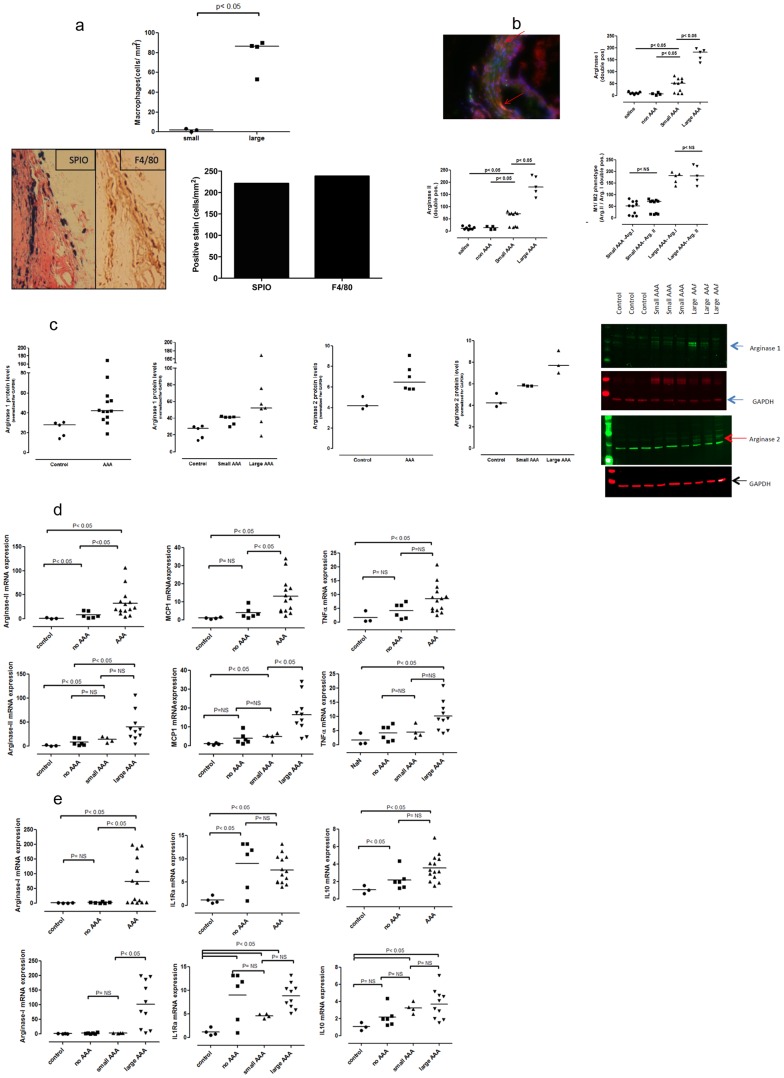
Macrophage expressions in AAA.(A) Analysis of macrophage accumulation in AAA. Prior to sacrifice, mice were injected with SPIO particles via lateral tail vein injections. SPIOs are phagocytosed by macrophages, and are evaluated histologically by Prussian Blue (PB) staining thereby providing an assessment of the presence and activity of macrophages. Top: Analysis using stereology showed a clear increase in positive iron bound macrophages in large aneurysms compared to small aneurysms (small AAA n = 3, large AAA n = 4; p<0.05). Bottom right: Automated quantitative analyses of histological sections of PB and F4/80 stains for macrophages showed congruence in the degree of macrophage accumulation as detected by both methods. Data shown were obtained from analyses of large AAAs; however, similar results were noted for small AAAs (data not shown). Bottom left: Representative histological sections showing SPIO and F4/80 stains for macrophage. Parallel findings from F4/80 and PB stains demonstrates the fidelity of SPIO particles for delineating the presence and activity of macrophages. AAA, abdominal aortic aneurysm; SPIO, supraparamagnetic iron oxide; PB, Prussian Blue. (B) M1 and M2 macrophage phenotypes and AAA. Presence of markers of M1 (arginase II) and M2 (arginase I) in cross sections of normal and aneurysmal tissue was evaluated using immunofluorescence staining (control n = 7, no AAA n = 4, small AAA n = 10 and large AAA n = 5). Increased numbers of positive stains were observed in both small and large aneurysms for both arginase I and arginase II. Expression of arginase I and II were significantly more increased in larger aneurysms. (C) Western blot Analysis of markers of M1 and M2 phenotypes and AAA. Left panels: Protein expression of arginase I as measured by western blot shows a statistically significant increase in arginase I in AAA tissue versus control (control n = 5, AAA n = 13; p p<0.05). Expression of arginase I was higher in large AAA versus small AAA. The observed difference was statistically significant (small AAA n = 6, large AAA n = 7; p<0.05). Middle panels: Protein expression of arginase II as measured by western blot shows small but statistically significant increases of arginase II in AAA tissue versus control (control n = 3, AAA n = 6; p<0.05). Expression of arginase II shows statistically significant differences between control, small and large AAA (small AAA n = 3, large AAA n = 3; p<0.05). Right panel: Representative images of western blot for arginase I and II. (D) Gene expression analysis of markers of M1 phenotype and AAA Left panel: Arginase II gene expression is significantly increased in tissues from both AAA (>23 fold, n = 14) and no AAA (>6 fold, n = 6) mice versus controls (n = 3). The difference between mice with and without AAA (>3 fold) is statistically different. In both small (n = 4) and large AAA (n = 10) the expression of arginase II is significantly different compared to control; however differences between small/large and small/no AAA were not significant. Middle panel: AAA mice had increased expression of MCP1 (>9 fold) compared to those without AAA and controls; both small and large AAA mice had increased expression of MCP1 (p<0.05) compared to controls, and the difference between small and large was significant (p<0.05; control n = 3, no AAA n = 6, small AAA n = 4 and large AAA n = 10). Right panel: TNF-α expression was significantly increased in the presence of AAA (>7 fold increase versus controls). Although both small and large AAA show increased expression (small >4 fold, n = 4, large >9 fold) only the latter differed significantly from controls. Observed differences between large and small AAA were not statistically significant (control n = 3, no AAA n = 6, small AAA n = 4 and large AAA n = 10). (E) Gene expression analysis of markers of M2 phenotype and AAA Left panel: When the size of aneurysm is considered we observed that arginase I expression in small AAA did not significantly differ from that of control but did differ significantly from the expression in large AAA (control n = 3, no AAA n = 6, small AAA n = 4 and large AAA n = 10). Middle panel; IL1Ra gene expression is increased significantly, >6 fold in both AAA and non AAA versus controls. Differences observed between small and large AAA were not significant (control n = 3, no AAA n = 6, small AAA n = 4 and large AAA n = 10). Right panel: Compared to mice in the control group, the IL10 gene expression is significantly increased in mice with AAA (>3 fold). Both small and large AAA differed significantly from control, however differences between small and large were not statistically significant (control n = 3, no AAA n = 6, small AAA n = 4 and large AAA n = 10).